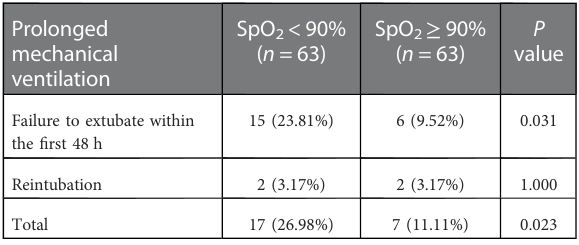
TABLE 2 Frequency of prolonged mechanical ventilation-associated events.